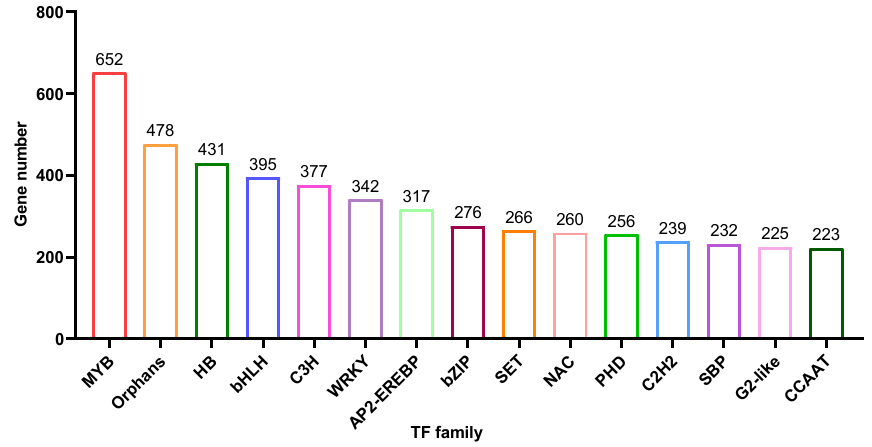
Figure 6. Transcription Factor (TF) were predicted into 80 subgroups, and the histogram showed the abundance of the top 15 subgroups.